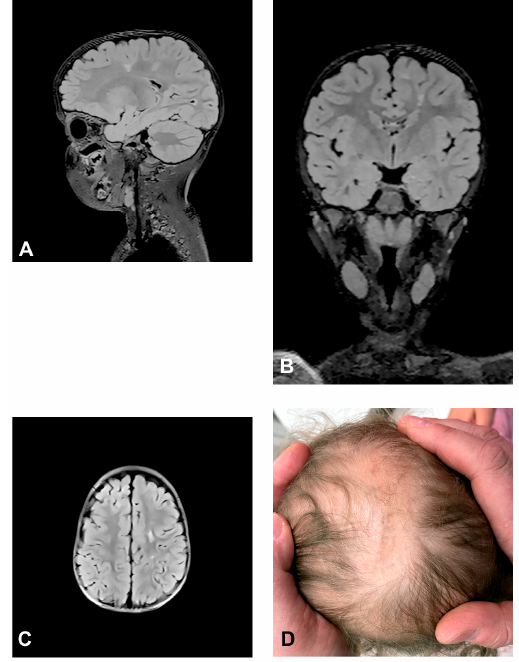
Figure 3. (Case 3) Sagittal ( A ), coronal ( B ) and axial ( C ) T2 FLAIR magnetic resonance images at the age of 2.5 showing small foci of hyperintensities, which appear in a band and triangle-like shape, spreading from subcortical white matter to the left lateral ventricle similarly to radial migration lines. ( D ) IP skin changes in the form of Blaschko lines on the same side of the scalp where the small foci of hyperintensities were